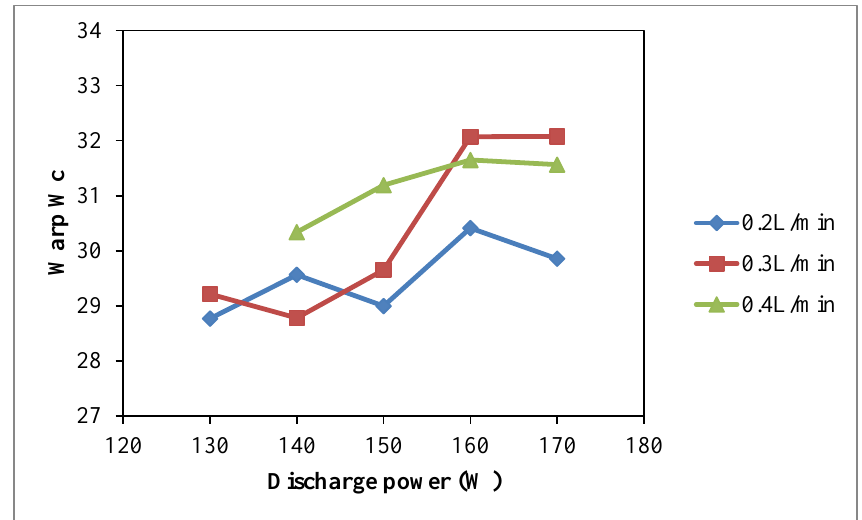
Figure 2. Effect of discharge power on warp W c (Discharge power: 130 W, 140 W, 150 W, 160 W and 170 W; Oxygen flow rates: 0.2 L/min, 0.3 L/min and 0.4 L/min; Jet travelling speed: 5 mm/s and Jet-to-substrate distance: 3 mm).